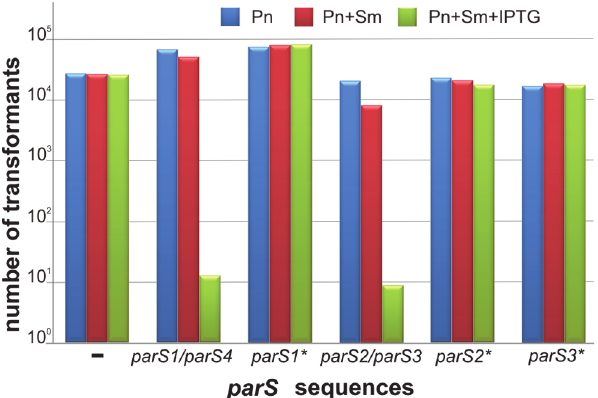
Fig 2. ParB silencing test for wild type and mutated versions of parS . E . coli DH5 α transformants carrying pGB2 derivatives with individual wt parS sequences or their mutated versions were transformed with pKLB2 ( tacp-parB P . a . ). Three independent transformation experiments were conducted and representative results are demonstrated. Undiluted transformation mixtures and their 10- and 100-fold dilutions were plated on three types of selection plates. Numbers of colonies growing on L-agar plates with Pn (blue bar), Pn and Sm (red bar), and double selection plates with 0.5 mM IPTG (green bar) are shown for the undiluted